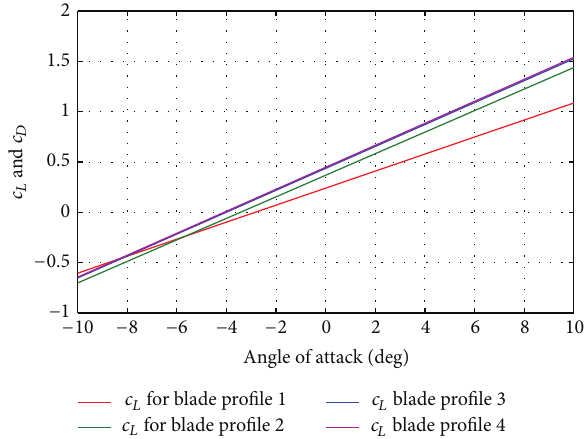
Figure 3: Original and linearized blade profiles. As it isobserved the linearization is made piecewise and the error between the original and the linearized data is